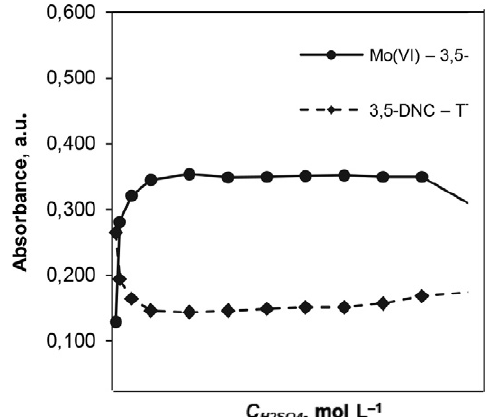
Figure 2. Absorption spectra of the complex Mo(VI)‒3,5-DNC‒ TTC in CHCl 3 against 3,5-DNC‒TTC extract vs. acidity of the